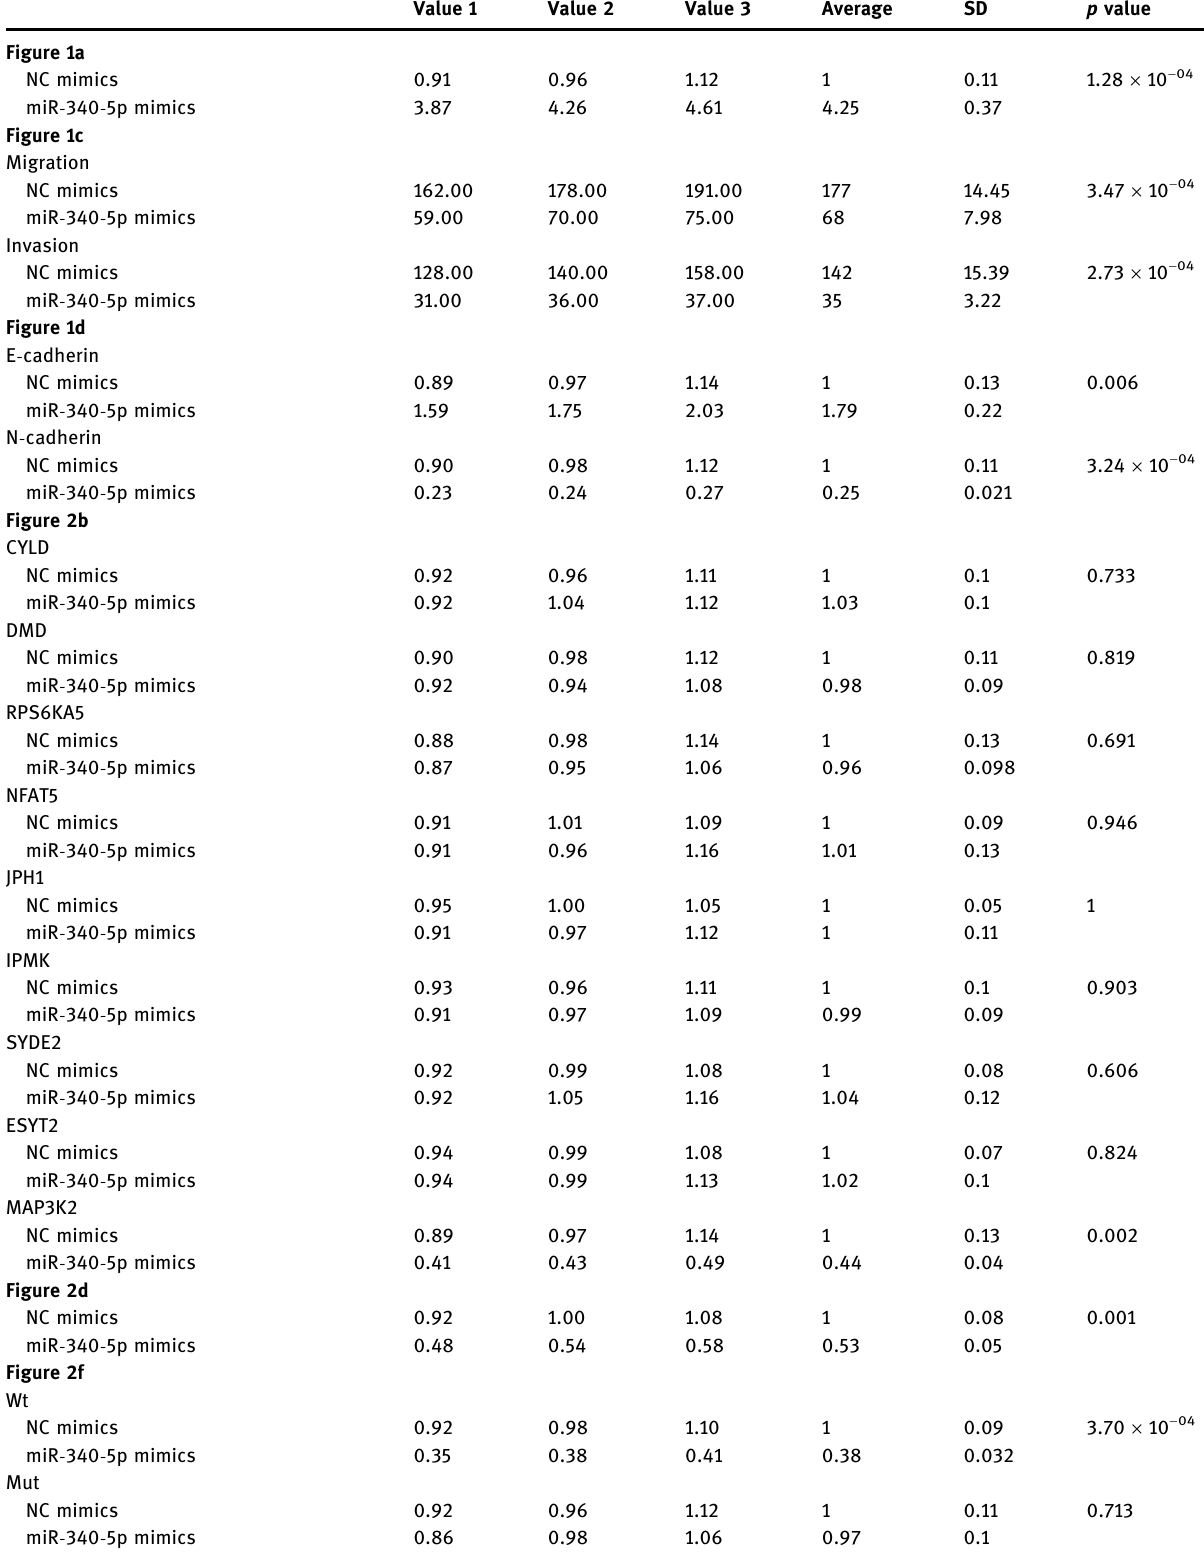
Table 2: Data from SPSS